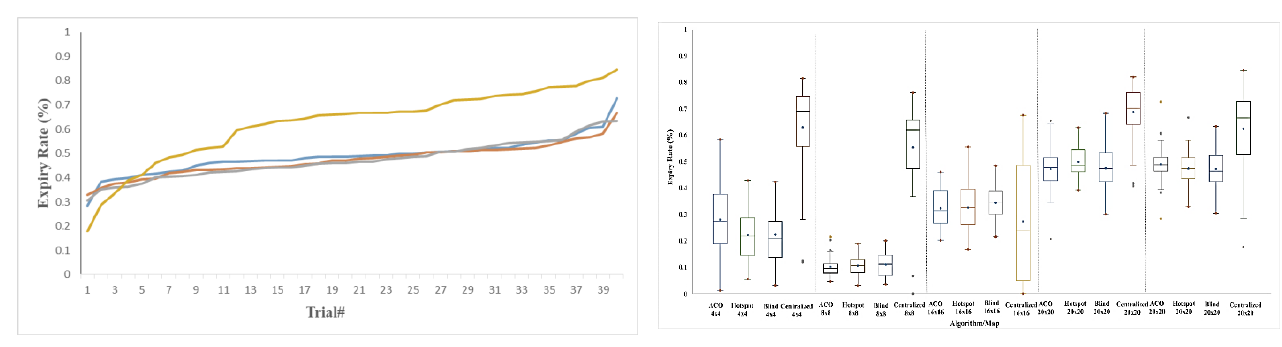
Figure 11. Robustness results for 40 trials with different setups. The results are ordered from smallest to largest for better representation ( a – f ).